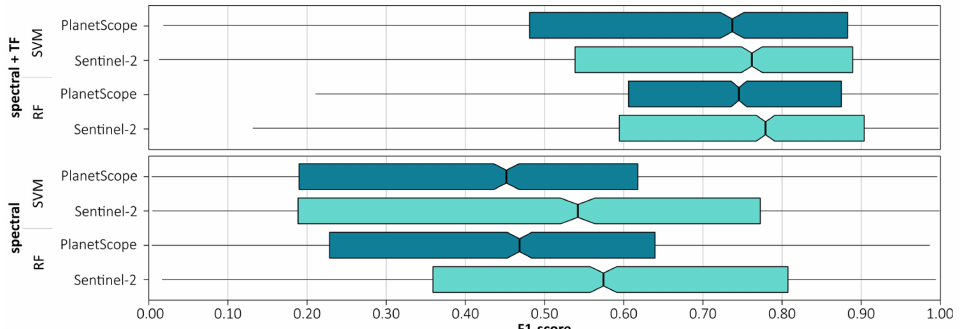
Figure 10. Comparison of single date classification (19 May 2022) between Sentinel-2 and PlanetScope data. F1-score values for dominant tree species based on 100 iterations. TF, topographic features based on Shuttle Radar Topography Mission data: digital elevation model, and slope and aspect maps.